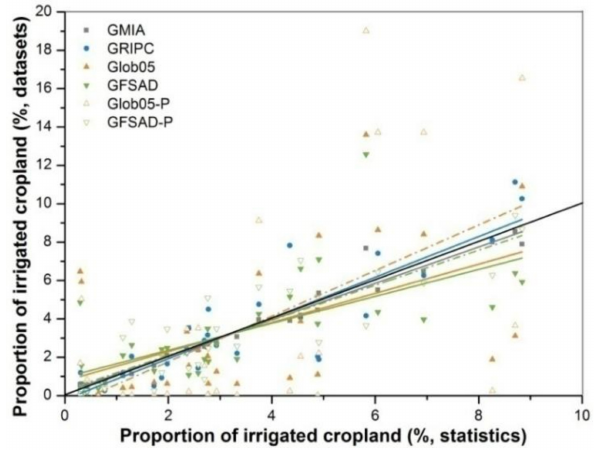
Figure 3. Regression of provincial proportion of irrigated cropland. Solid points correspond to solid lines of the same color, while the hollow ones correspond to dashed lines of the same color. The solid black line is the ideal line (slope = 1, intercept = 0) that symbolizes ideal dispersion and fitting. Slopes and intercepts of fitting lines, which are indicators of fitting lines’ deviation with ideal line,